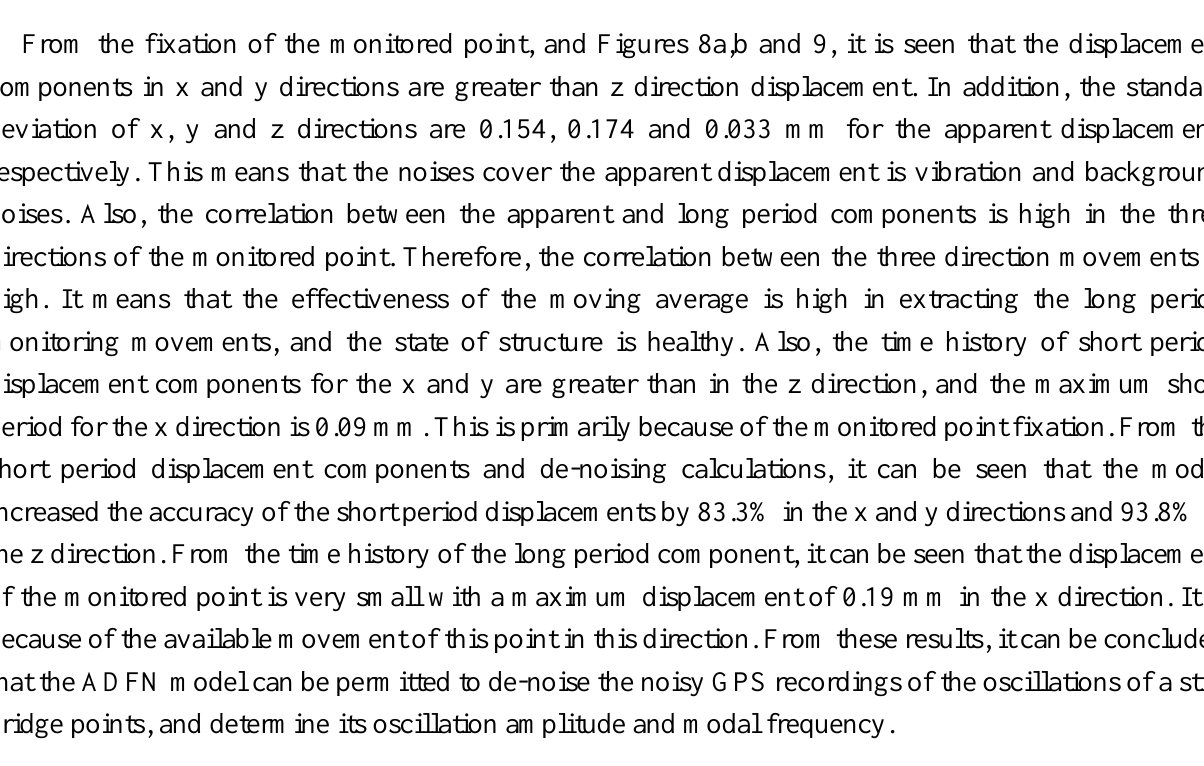
Figure 9. Long (left) and Short (right) period displacement for ( a ) x, ( b ) y